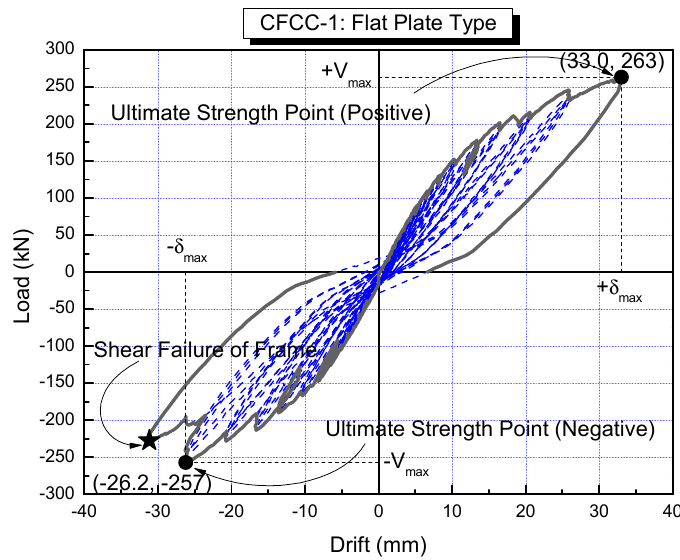
Figure 8. The CFCC-1 specimen following the cyclic loading tests.